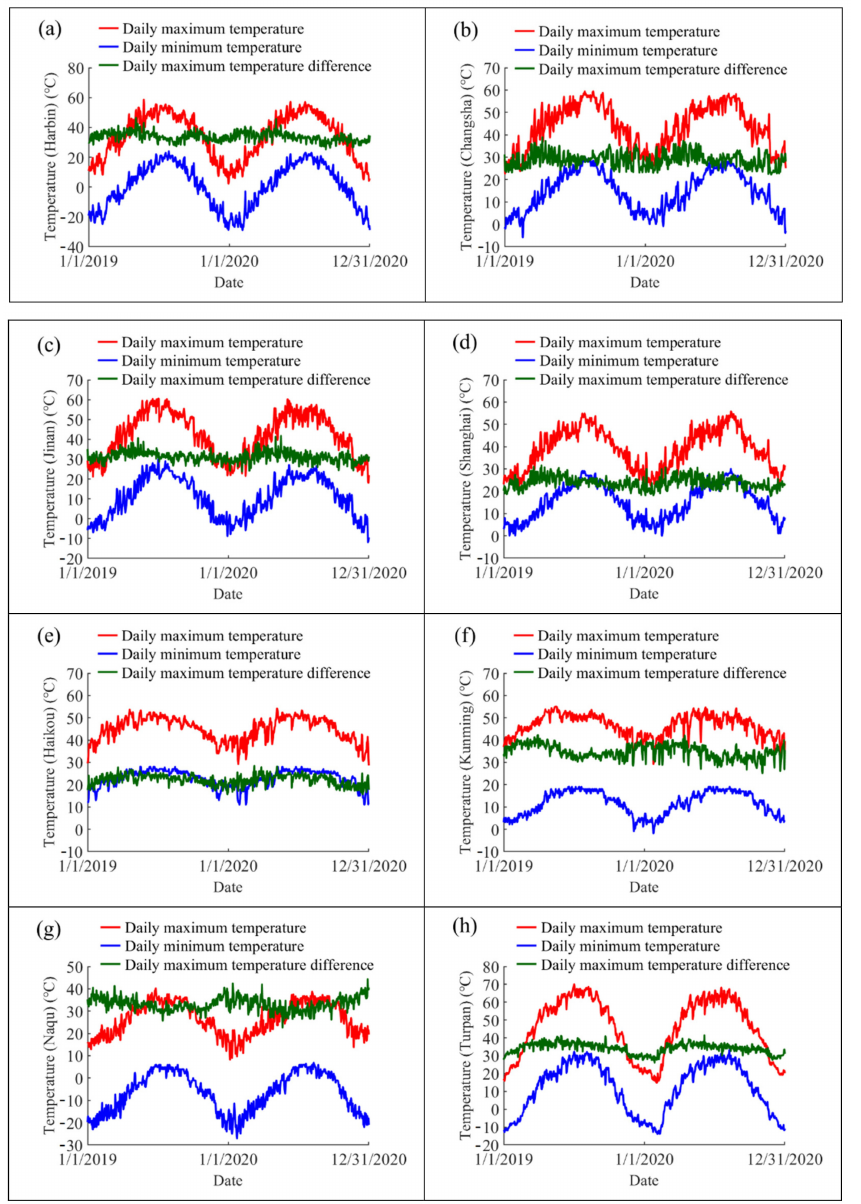
Figure 14. Daily maximum temperatures, daily minimum temperatures, and daily maximum temper- ature differences of steel beams in different cities: ( a ) Harbin; ( b ) Changsha; ( c ) Jinan; ( d ) Shanghai; ( e ) Haikou; ( f ) Kunming; ( g ) Naqu; and ( h )